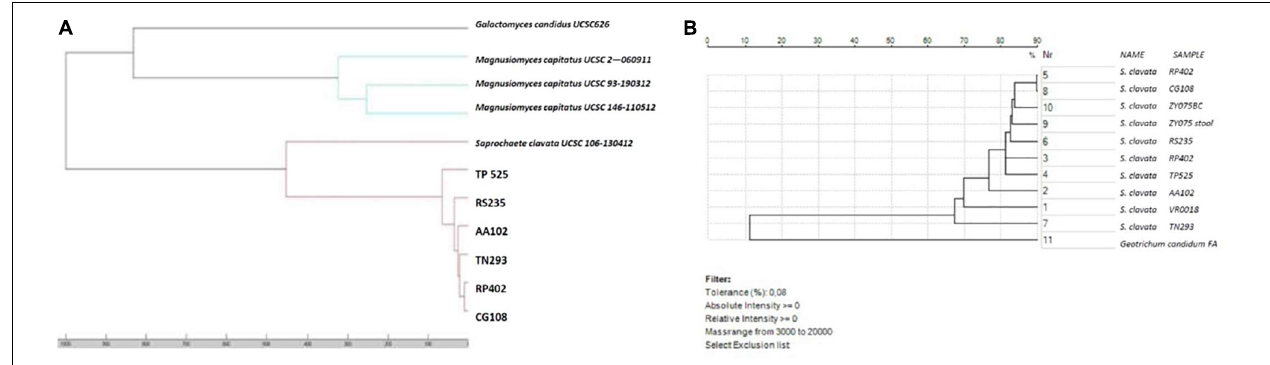
FIGURE 5 | Correlation-based dendrograms obtained by (A) MALDI-TOF MS (Bruker Daltonics) and (B) MS-Vitek Saramis (bioMerieux, Marcy l’Etoile, France).